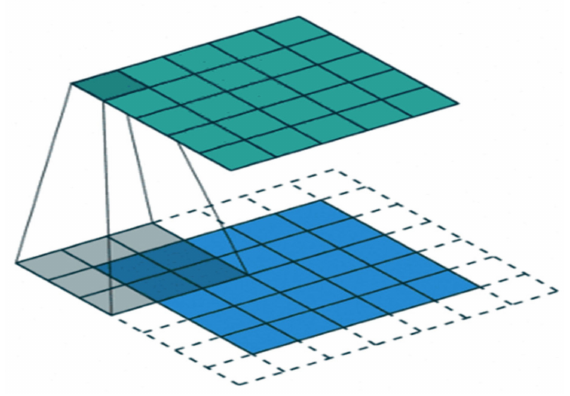
Figure 8. Padding [8].